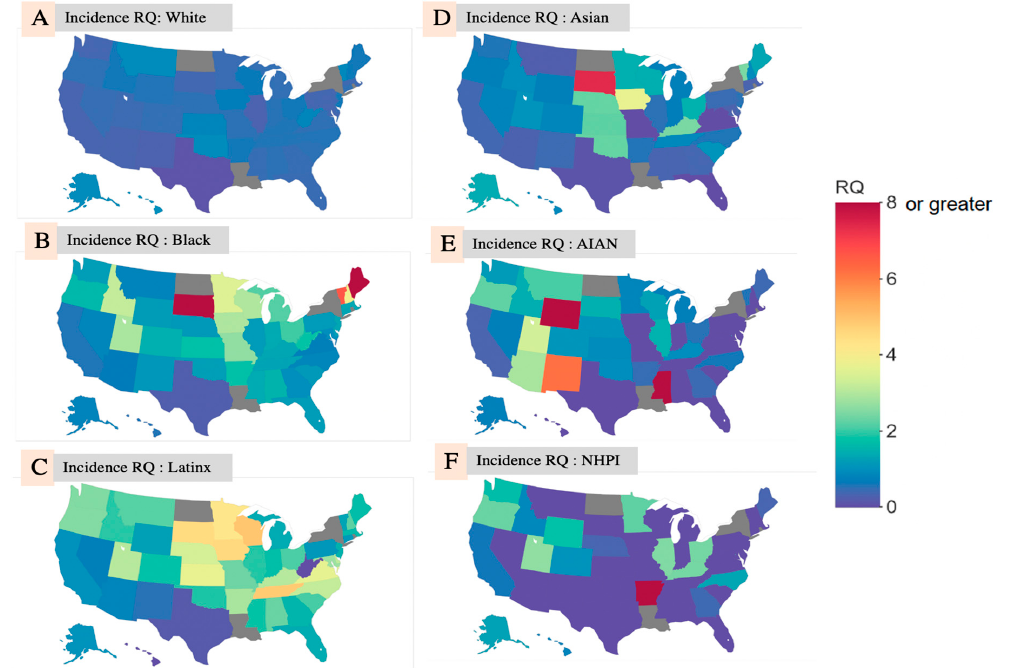
Figure 1. Choropleth Maps of COVID-19 Incidence RQ by State among ( A ): White people; ( B ):